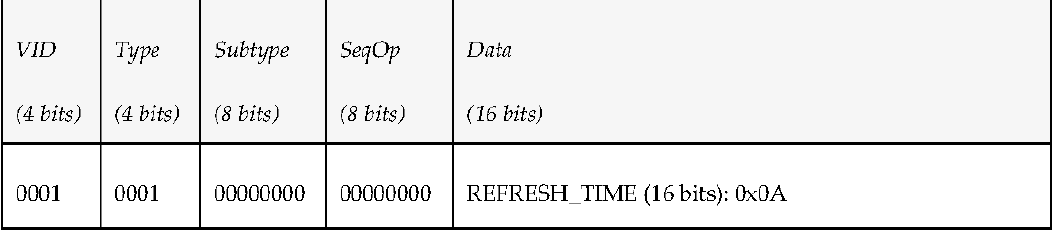
Figure 6. Appearance of the PDU used to request environment information.